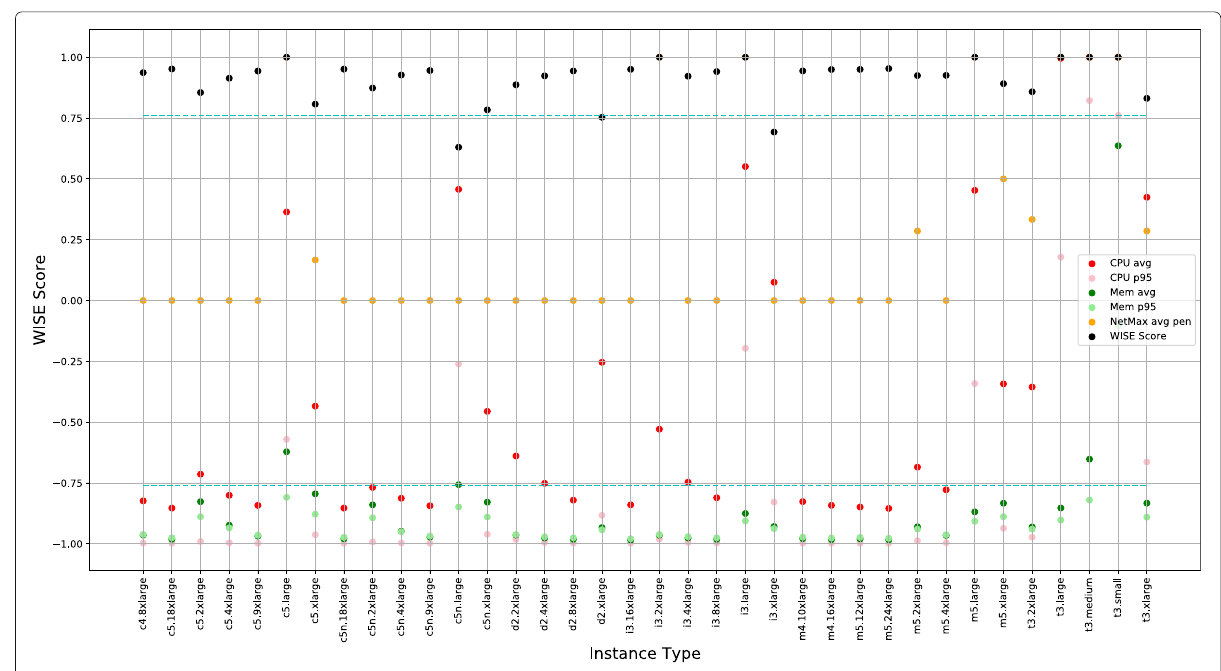
Fig. 8 WISE scores using the hyperbolic tangent function and (cid:4) 1 -norm for Streaming Workload